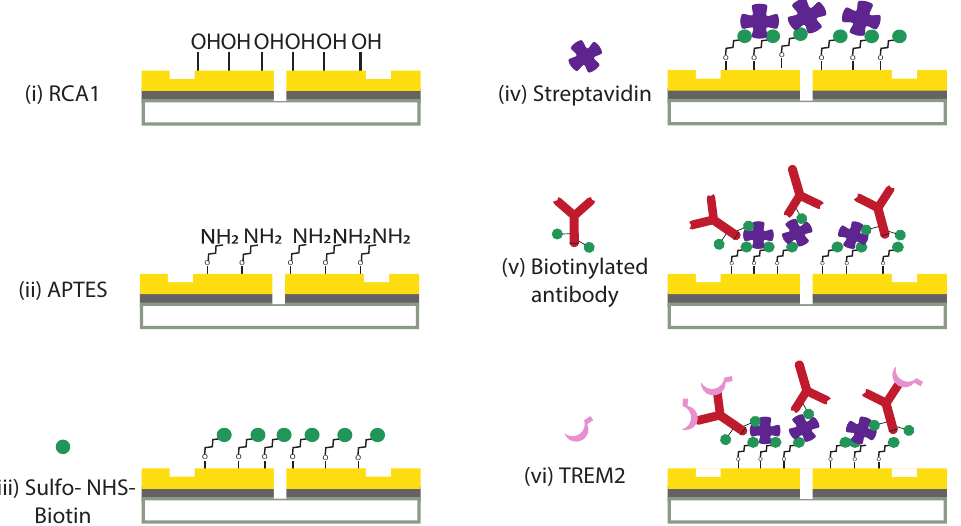
Figure 2. Surface immobilization protocol for capture of TREM2 in solution. Chip surface was treated with ( i ) an RCA1 cleaning procedure followed by ( ii ) (3-Aminopropyl)triethoxysilane (APTES) to form an amino-terminated surface. Sulfo-NHS-biotin (sulfo-N-Hydroxysulfosuccinimide biotin) covalently attaches to the amino groups of the surface ( iii ) and subsequently captures streptavidins ( iv ). Finally, the streptavidin functionalized chip is bound by the biotinylated TREM2 antibody ( v ) for sensing of the TREM2 molecule ( vi ). The green dot in ( v ) represents the sulfo-NHS ester of biotin that acts as the biotinylation reagent and allows to form a stable bond between the antibody and the streptavidin already bound to the sensor surface, as reported in ( iv